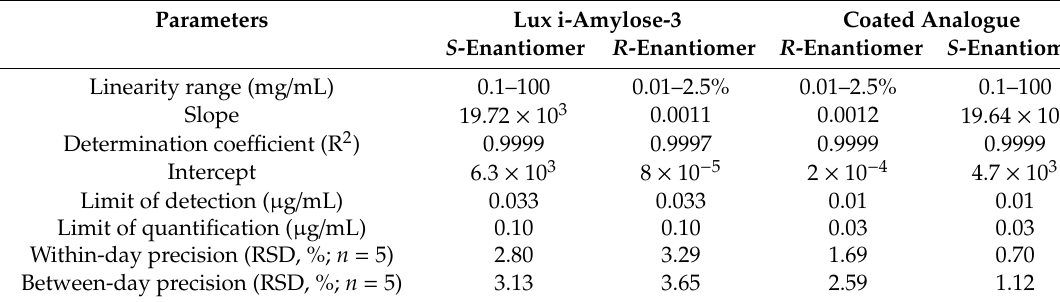
Table 2. Summary of the calibration results for